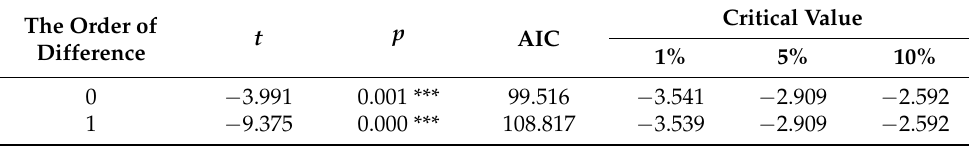
Table 8. Panel data stationariness test